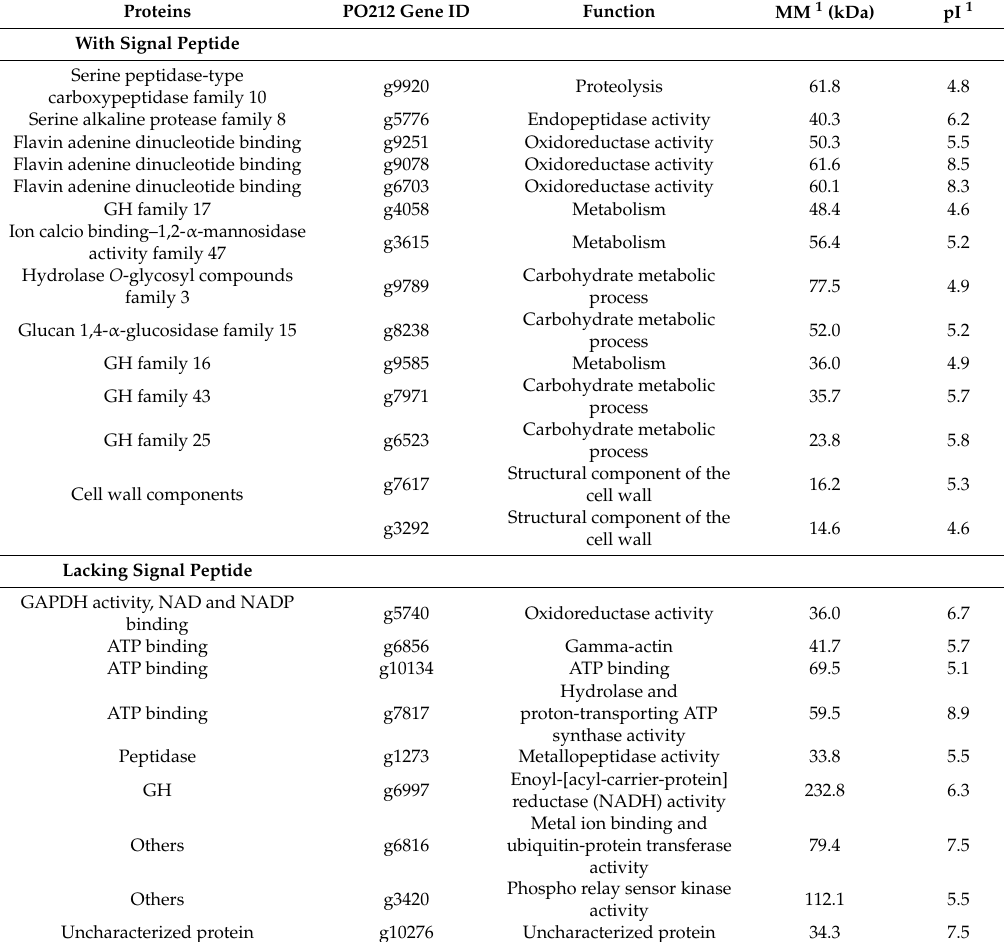
Table 9. Extracellular proteins identified (class, Penicillium rubens strain 212 (PO212) gene ID and description) in the high molecular mass protein fraction